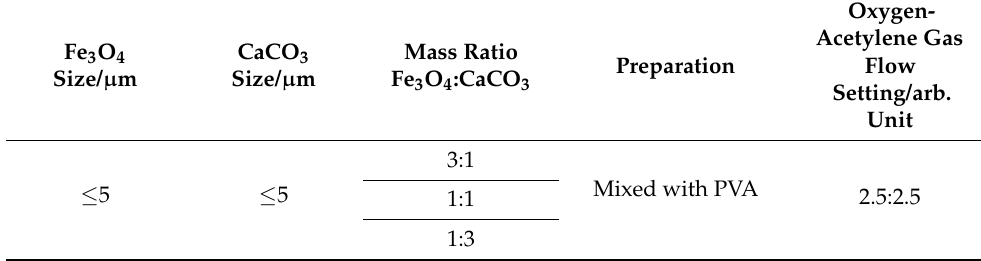
Table 9. Parameters to evaluate the e ff ects of gas fl ow se tt ing.